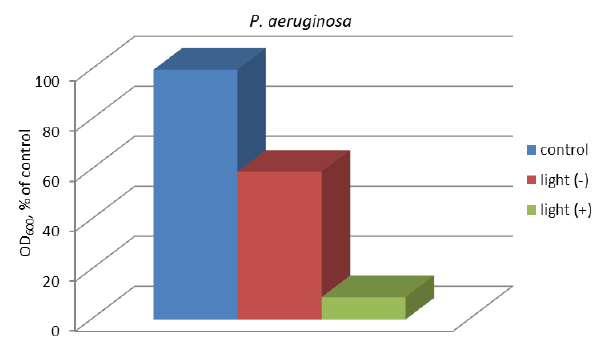
Figure 8: Effect of light irradiation on the antibacterial effect of cotton fabric treated with compound E.